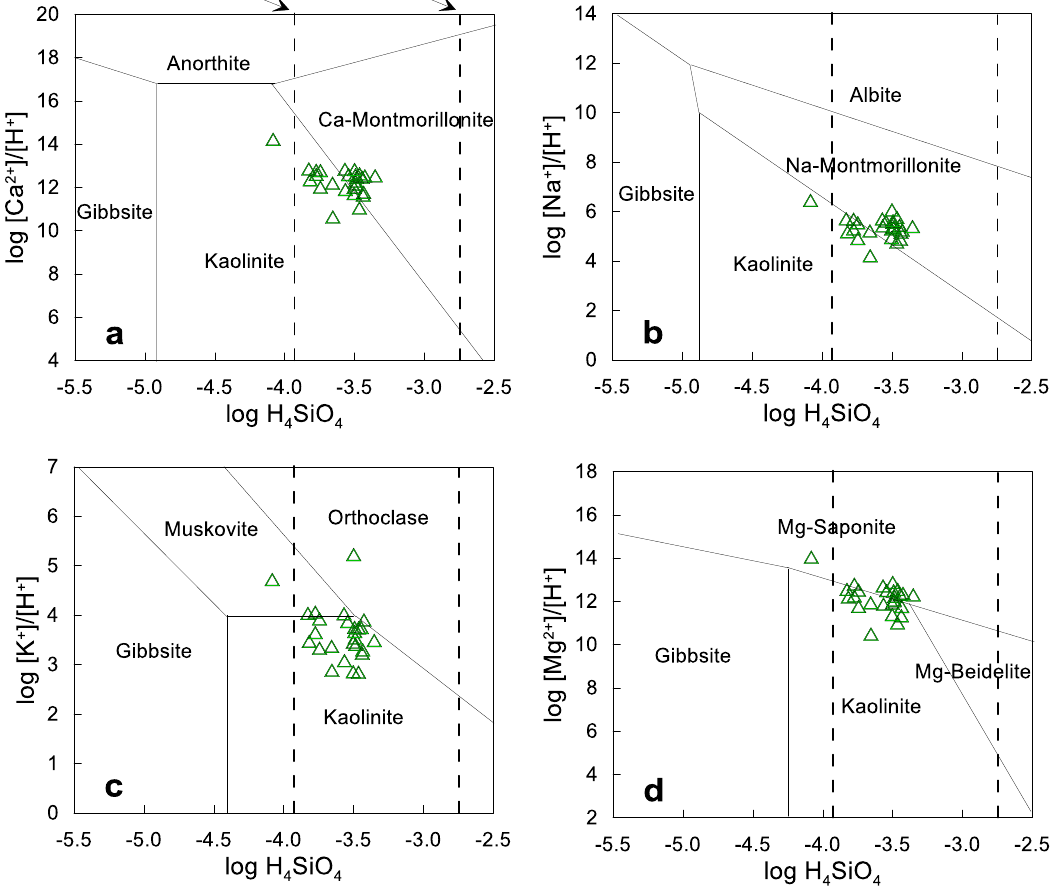
Figure 6. Stability of ( a ) Ca-Al silicate phases; ( b ) Na-Al silicate phases; ( c ) K-Al silicate phases; and ( d ) Mg-Al phases in aqueous solution at 25 °C and 1 atm pressure with groundwater data of the study area.